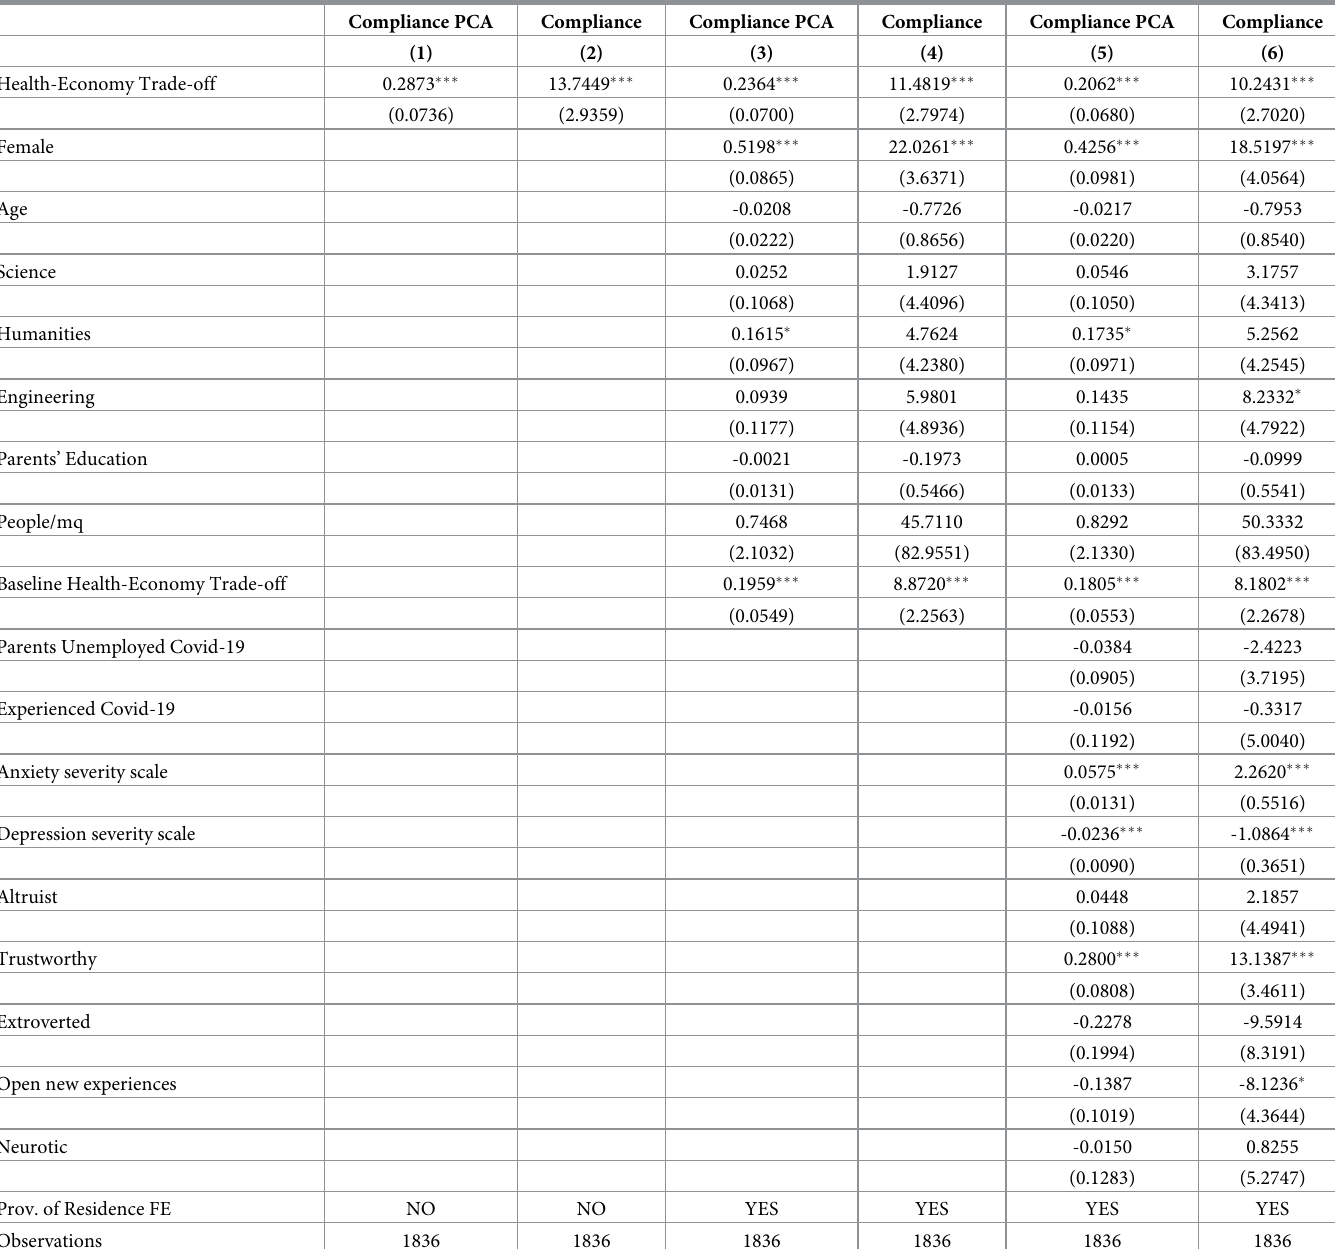
Table 4. Preferences for health centered policies and intention to adhere to prescribed